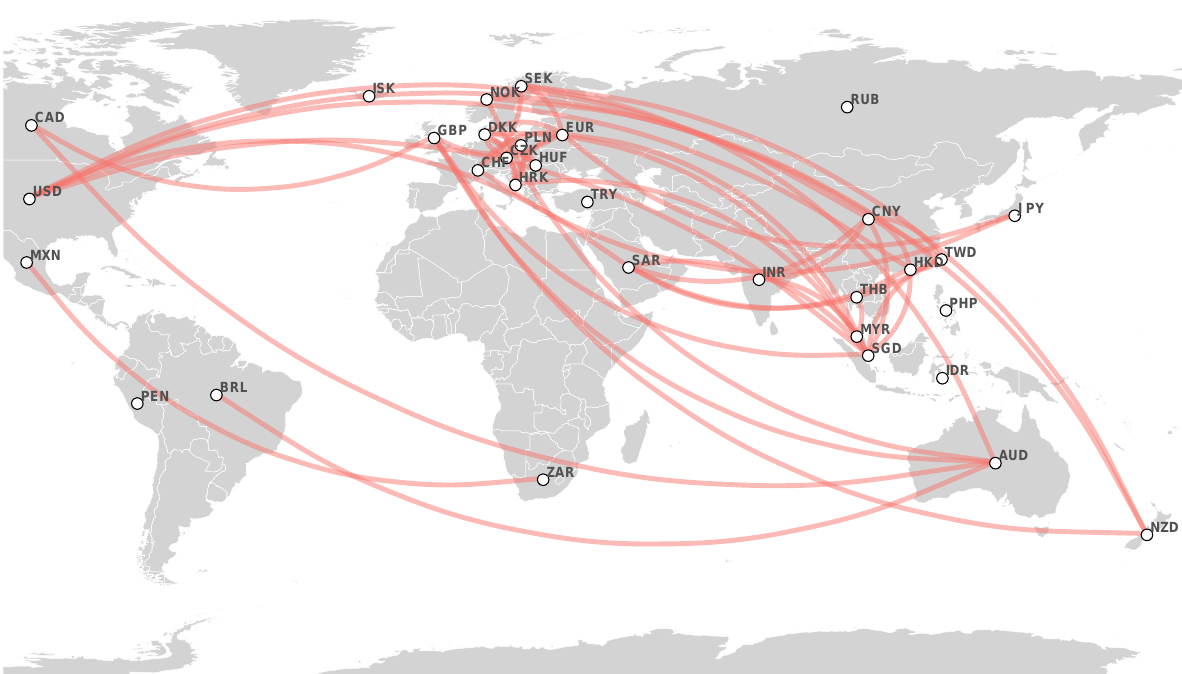
gray Figure 9. Estimated currency network based on 2021 foreign exchange markets